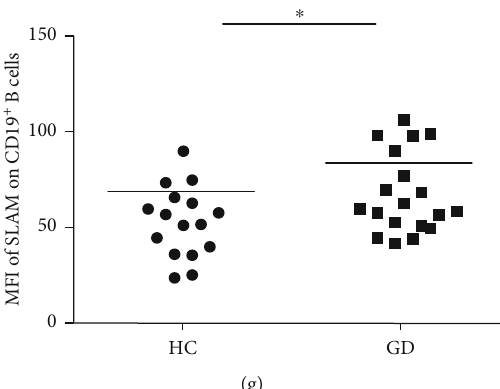
Figure 1: The expression of SLAM and SAP in the peripheral blood of the patients with GD and the healthy controls. The levels of (a) SAP mRNA and (b) SLAM mRNA in circulating CD4 + T cells from the patients with GD and the healthy controls. The mean fl uorescence intensity (MFI) of SAP was analyzed by fl ow cytometry (FCM) in circulating (c) CD4 + T cells and (d) CD4 + CXCR5 + T cells from the patients with GD and the healthy controls. The MFI of SLAM was analyzed by FCM on circulating (e) CD4 + T cells and (f) CD4 + CXCR5 + T cells from the patients with GD and the healthy controls. (g) The MFI of SLAM was analyzed by FCM on circulating CD19 + B cells from the patients with GD and the healthy controls. Each data point represents an individual subject; horizontal lines show the mean. ∗ P < 0 : 05 , n = 19 ; ns: no signi fi cant di ff